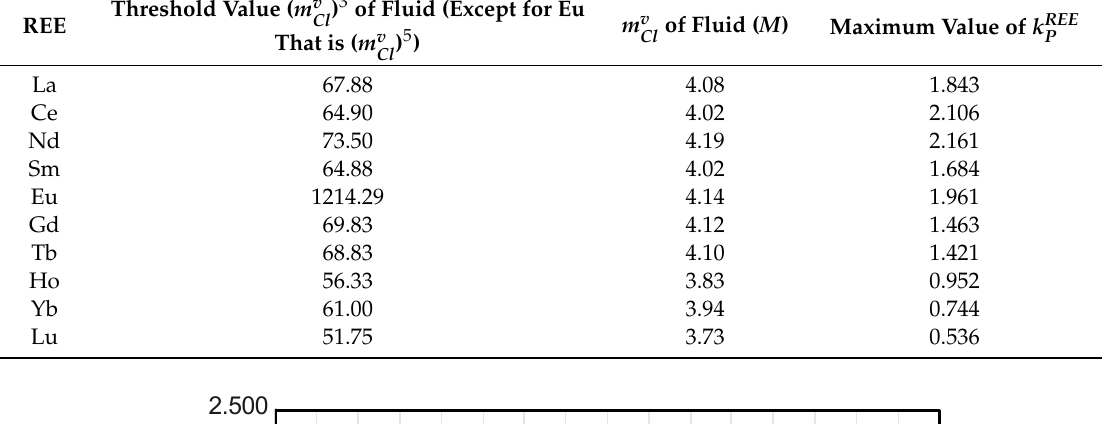
Table 3. Predicted Cl molality threshold values ( 𝑚 (cid:3004)(cid:3039)(cid:3049) ) 3 of magmatic fluids (note: for Eu, it should be ( 𝑚 (cid:3004)(cid:3039)(cid:3049) ) 5 ) and maximum values of REE fluid–granite melt partition coefficients of 𝑘 (cid:3017)(cid:3019)(cid:3006)(cid:3006) from this study. Cl Threshold Value ( 𝒎 𝑪𝒍𝒗 ) 3 of Fluid (Except for Eu That is REE